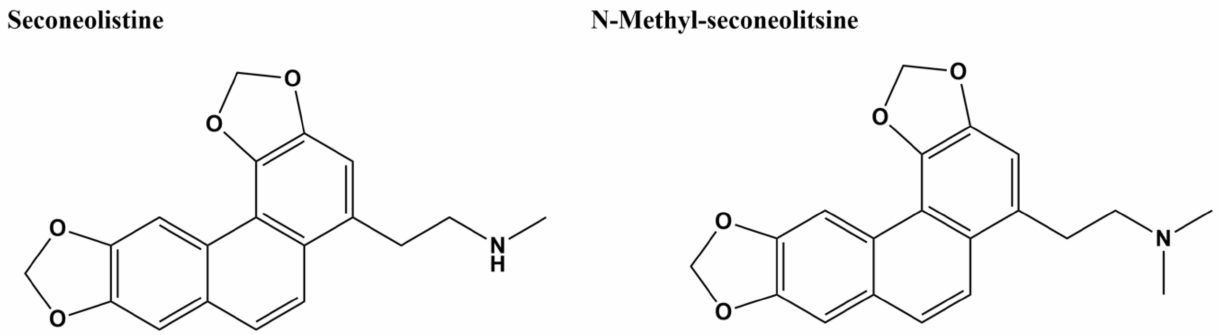
Figure 8. Alkaloids seconeolitsine (SCN) and N -methyl seconeolitsine ( N -SCN)